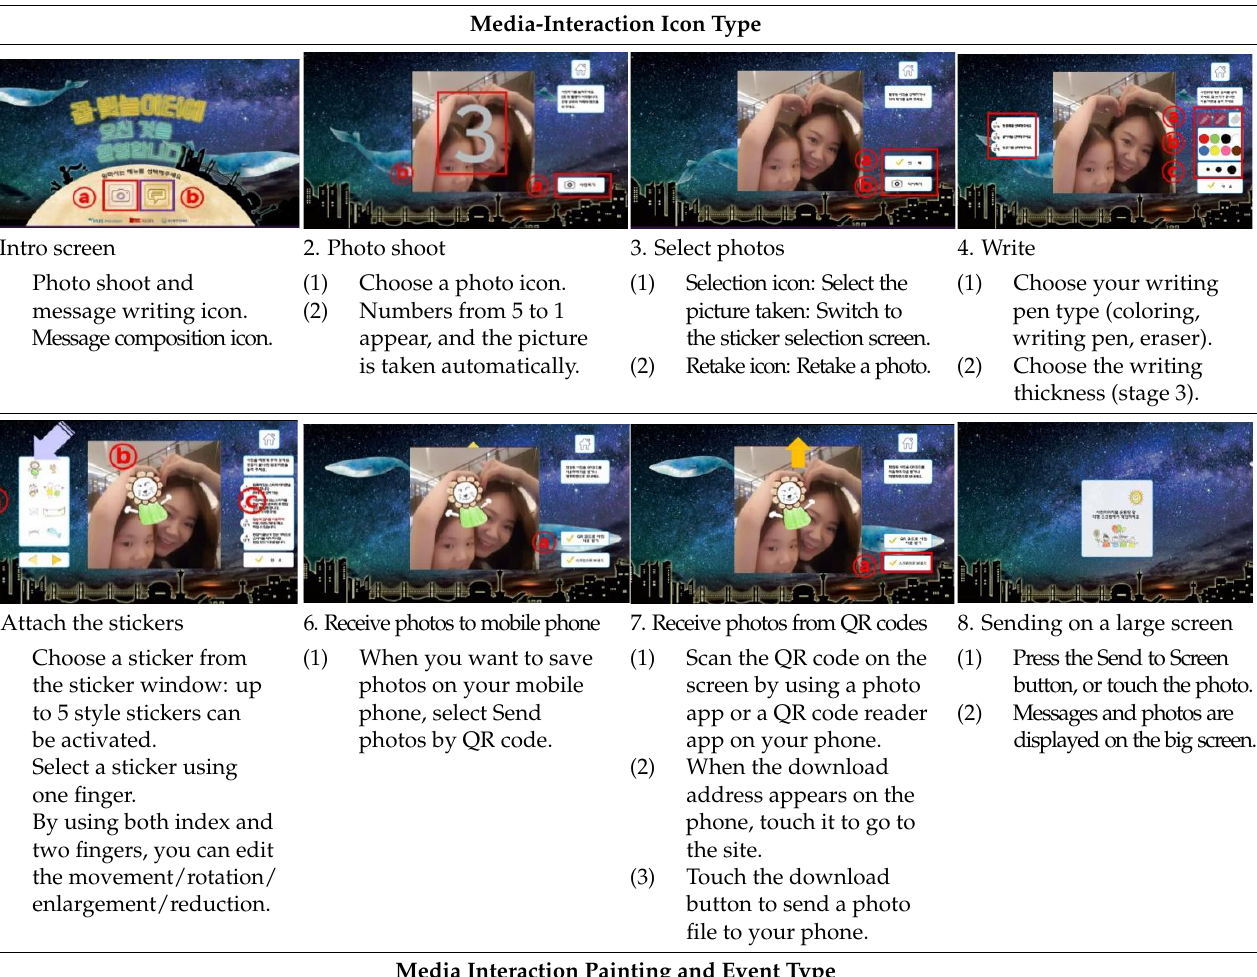
Table 5. User engagement media-interaction for the “Dream Light Cube,” project: Touch Kiosk 2; type programs: (1) icon type and painting and (2) event type.